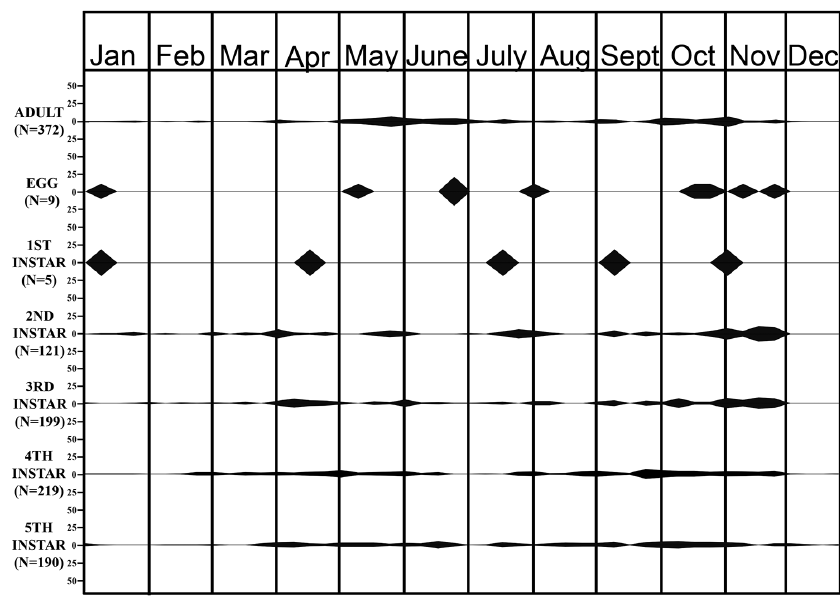
Figure 2. Field life cycle of M. major . Percentage in each sample of total individuals of same stage col- lected during 2005-2007 in Las Cruces, NM. Beginning and end points of each shaded area represent sample dates preceding and following collections of specimens,